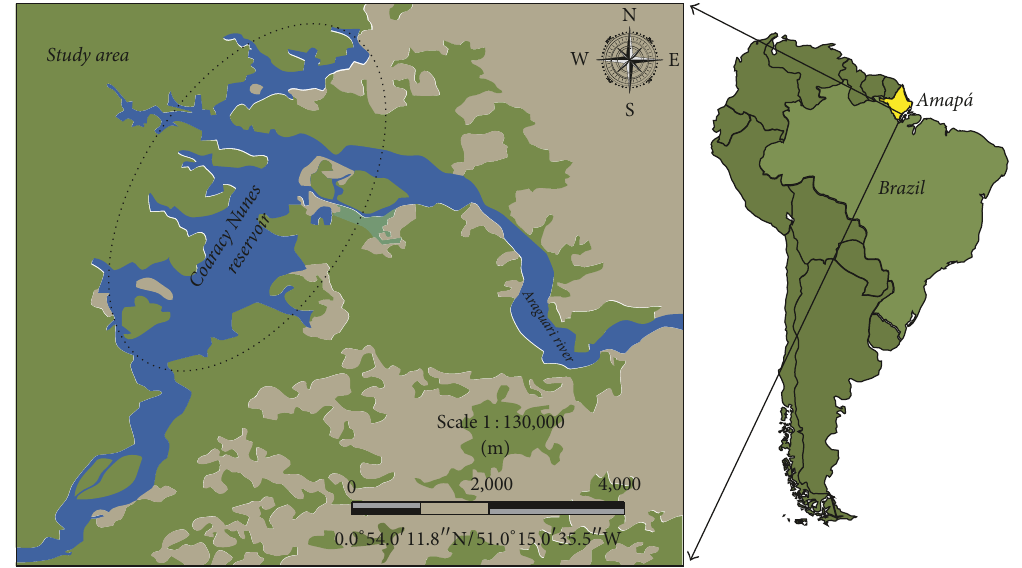
Figure 1: Study area: reservoir of the Coaracy Nunes hydroelectric power station in Ferreira Gomes, Amap´a, Brazil.